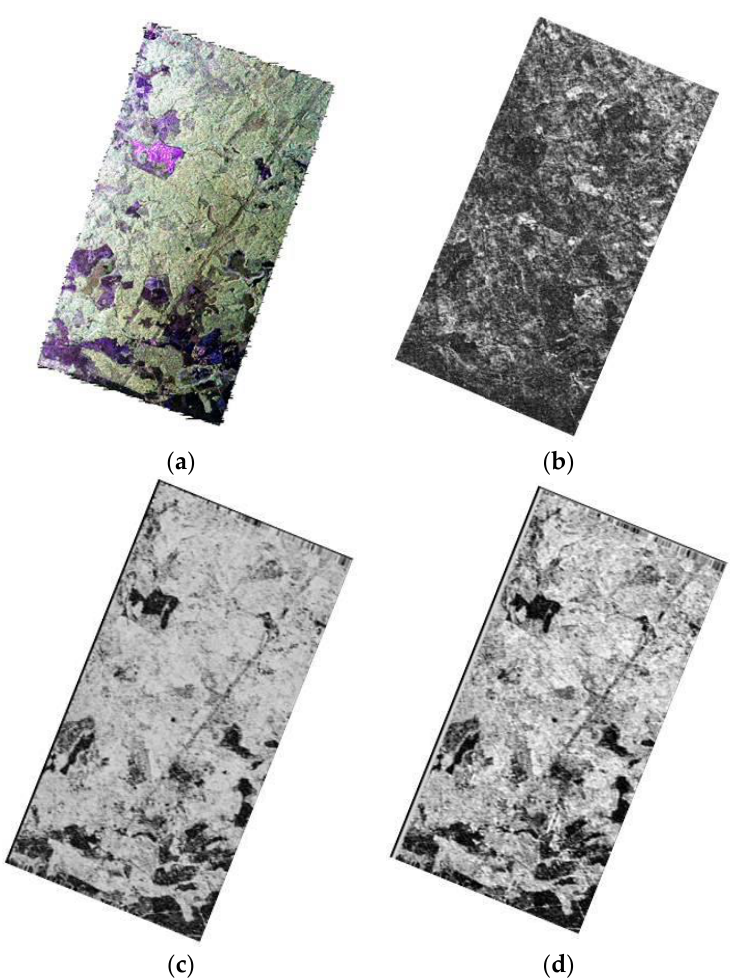
Figure 10. Height estimation on BioSAR2007 datasets for Remningstorp: ( a ) Pauli RGB; ( b ) phase difference; ( c ) three-stage inversion; and ( d ) species diversity based inversion.